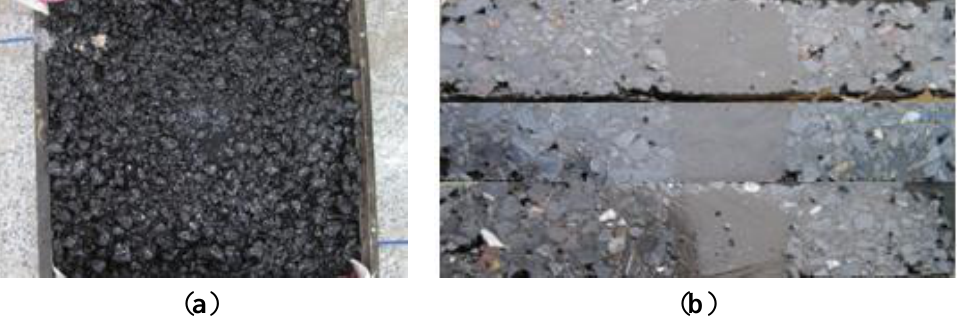
Figure 5. Cross-section of a wheel rutting test sample with the sensor embedded. ( a ) Wheel rutting test sample with optical fiber embedded; ( b ) Cross section of the test sample.